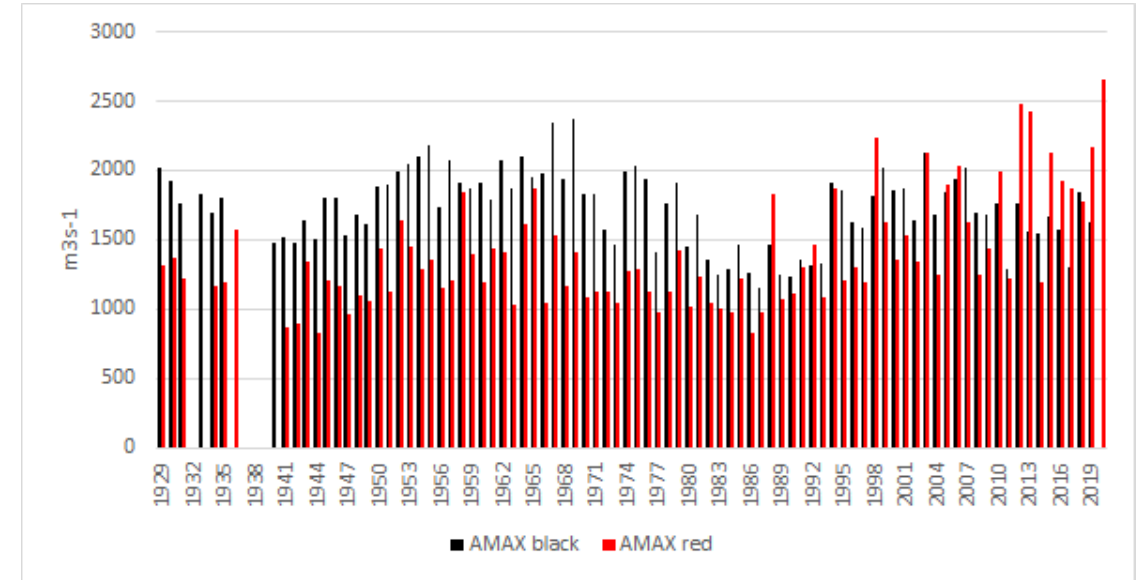
Figure A3. AMAX of the red and black flood at Niamey gauging station. Table A2. Results of the regression of AMAX (Q) with time and rainfall over the Niger river Basin at Niamey (standard